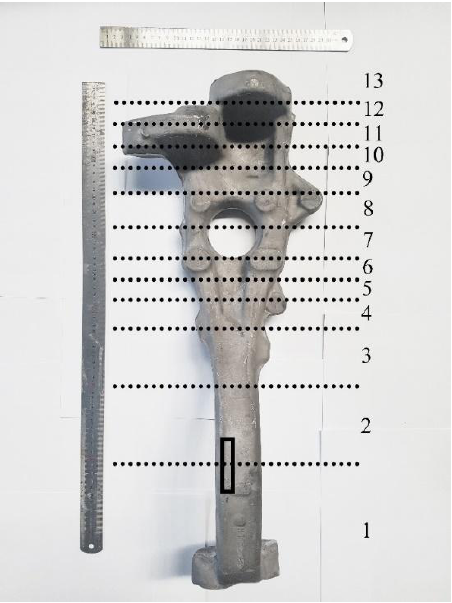
Figure 1. A steering knuckle produced by tailored additive casting (TAC), followed by forging and heat treatment. The length and maximum width of the knuckle are 68 cm and 26 cm, respectively. The TAC process consists of 13 steps; melt injected at each step is indicated by the dotted lines. Measurement samples for determining the ultimate tensile strength and elongation percentage were collected from the area indicated by the black box.